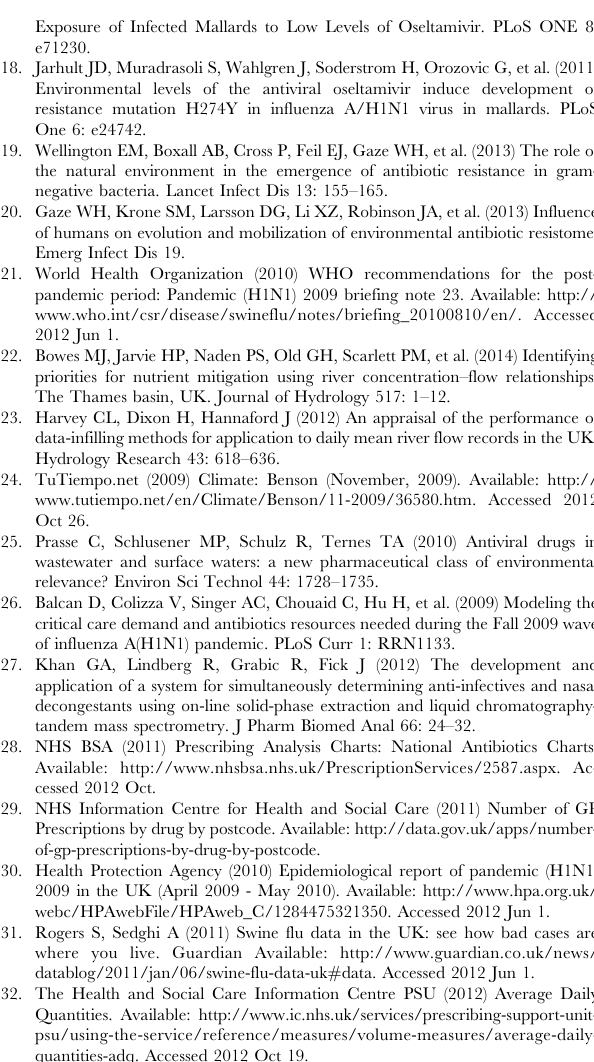
Figure S5B. Concentration of antibiotics and oseltamivir (ng/L) at all river sampling locations for each of the sampling dates: November 10, 2009. River sampling locations given sorted by population upstream with TC8 having the smallest population. Figure S5C. Concentration of antibiotics and oseltamivir (ng/L) at all river sampling locations for each of the sampling dates: November 16, 2009. River sampling locations given sorted by population upstream with TC8 having the smallest population. Figure S5D. Concentration of antibiotics and oseltamivir (ng/L) at all river sampling locations for each of the sampling dates: November 24, 2009. River sampling locations given sorted by population upstream with TC8 having the smallest population. Figure S5E. Concentration of antibiotics and oseltamivir (ng/L) at all river sampling locations for each of the sampling dates: March 15, 2010. River sampling locations given sorted by population upstream with TC8 having the smallest population. Figure S5F. Concentration of antibiotics and oseltamivir (ng/L) at all river sampling locations for each of the sampling dates: May